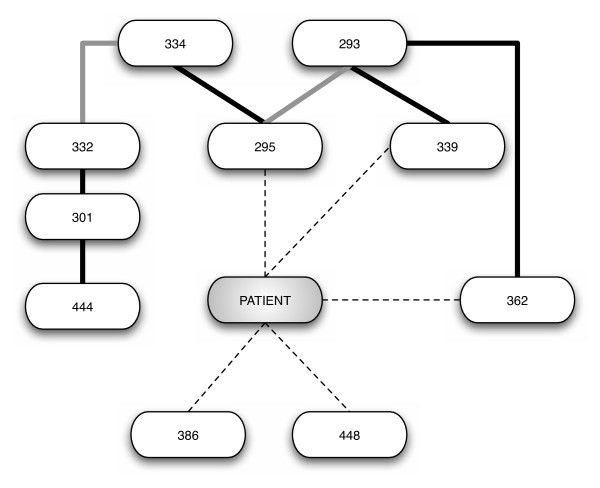
Bayesian network associations found between observed N-linked glycosylation sites. Representation of the Bayesian network analysis results, generated as described in the methods section. Only arcs with a bootstrap support of at least 70% are presented. Associations between patient ID and glycosylation sites are dashed. Associations between glycosylation sites that can be structurally explained are colored grey. Associations between glycosylation sites that cannot be structurally explained are colored black.